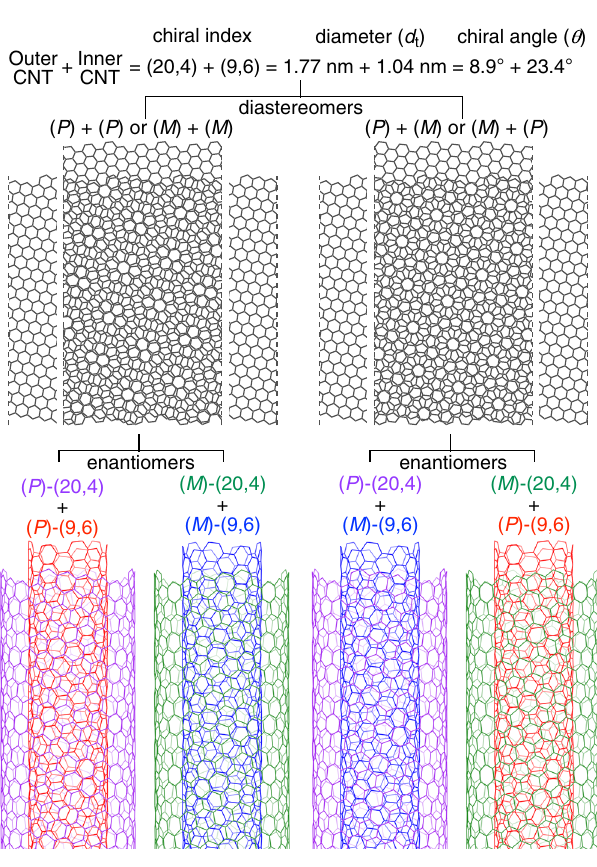
Fig. 1 Stereoisomerism of i-DWNT. An example of a combination of two helical CNTs, i.e., (20,4)- and (9,6)-CNTs, is shown. Combinations of two carbon layers in twisted orientations give rise to two diastereomers, each of them existing as a pair of enantiomers.